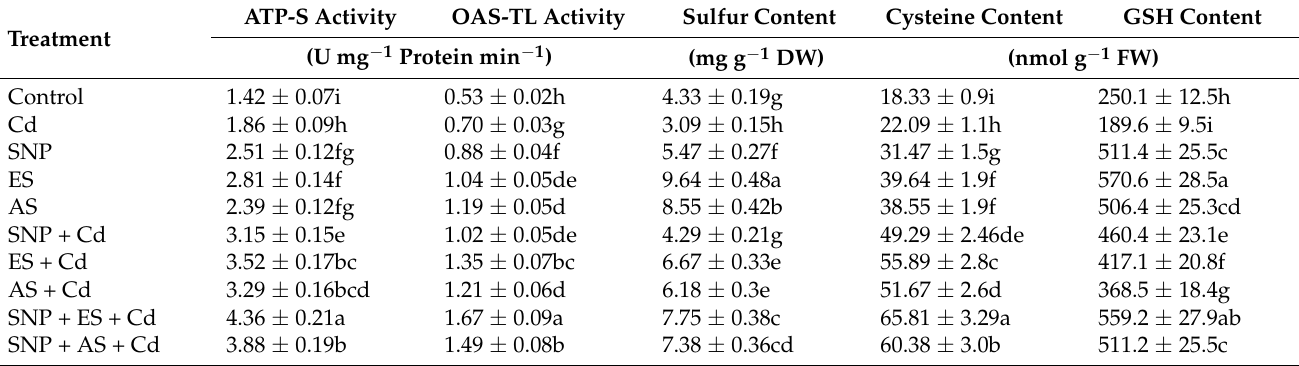
Table 4. Effect of 100 µ M SNP (NO donor) and 200 mg S kg − 1 soil of elemental sulfur (ES) or ammonium sulfate (AS) in the presence or absence of 200 mg Cd kg − 1 soil on activity of ATP-S, OAS-TL, and content of S, cysteine, and GSH in mustard ( Brassica juncea L. cv. Giriraj) at 30 days after sowing. Data are presented as treatment mean ± SE ( n = 4). Data with the same letter are not significantly different as determined by LSD test at p ≤ 0.05. ATP-S, ATP-sulfurylase; Cys, cysteine; Cd, cadmium; DW, dry weight; FW, fresh weight; GSH, reduced glutathione; OAS-TL, O -acetylserine (thiol) lyase; S, sulfur; SNP, sodium